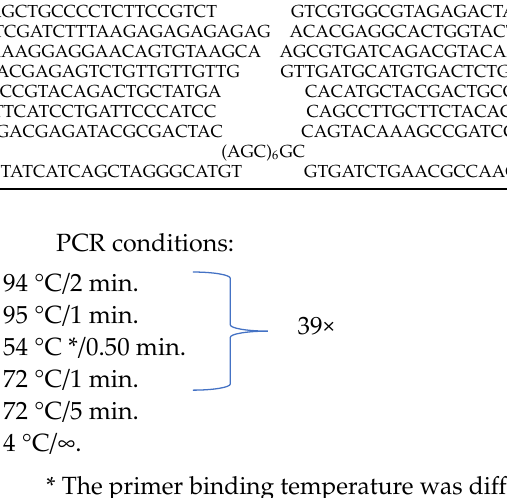
The polymerase chain reaction (PCR) was conducted in a BIO-RAD T1000 thermocy- cler. Reagents from Promega were used to prepare the mixture. The composition of the reaction mixture volume (μL) of reaction components per 20 μL sample: Buffer (5×